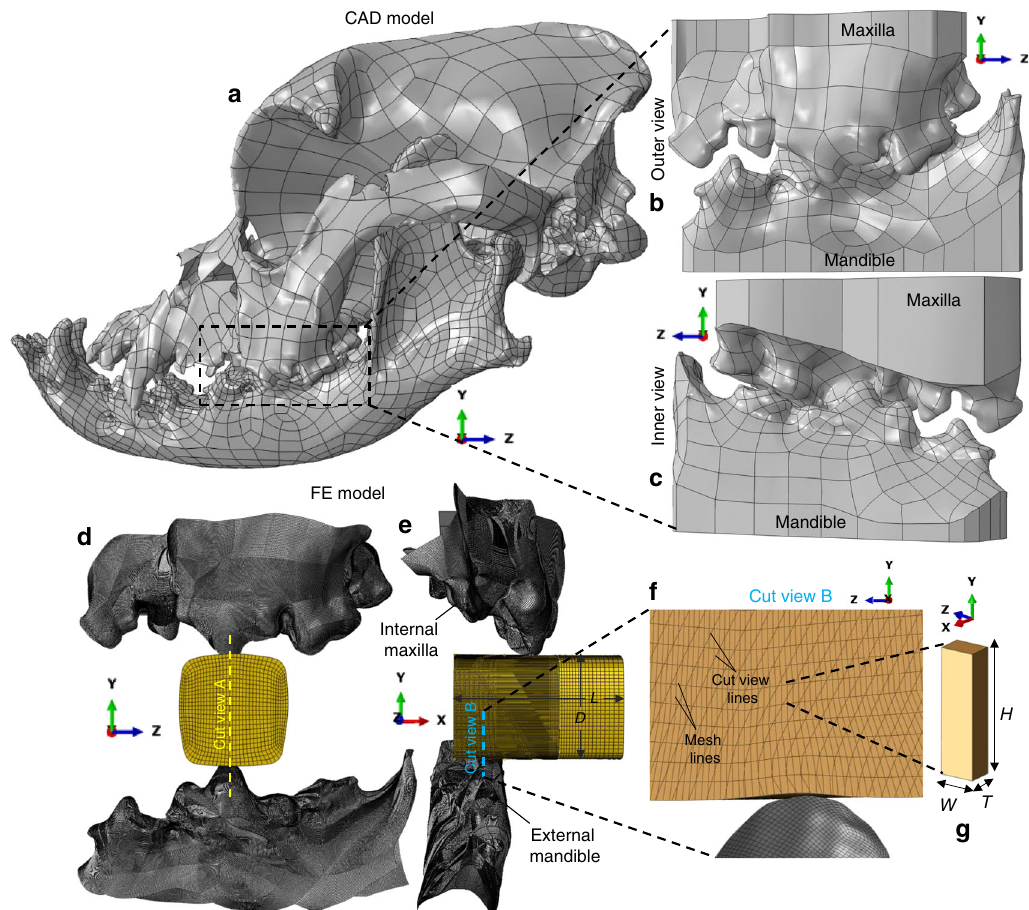
Fig. 3 Illustration of the mastication FE model construction steps. a shows side view of the boxer skull CAD geometry imported in ABAQUS CAE 39 ; dashed box denotes the cropped region used in the FE model. b , c show outer and inner side view of cropped skull geometry, respectively; both jaw surfaces are modi fi ed by adding fl at faces in the remote of the teeth in order to obtain a closed volume essential for the 3D-printing process. d , e depict front and side views, respectively, of the FE meshed model assembly, along with positions of cut views A (used in Fig. 4d) and B and food item dimensions: length 20 mm, and effective diameter 12.6 mm. f and g correspond to cut view B showing food mesh design and element con fi guration details, de fi ned by dimensions: height 0.3 mm, width 0.1 mm and thickness 0.05